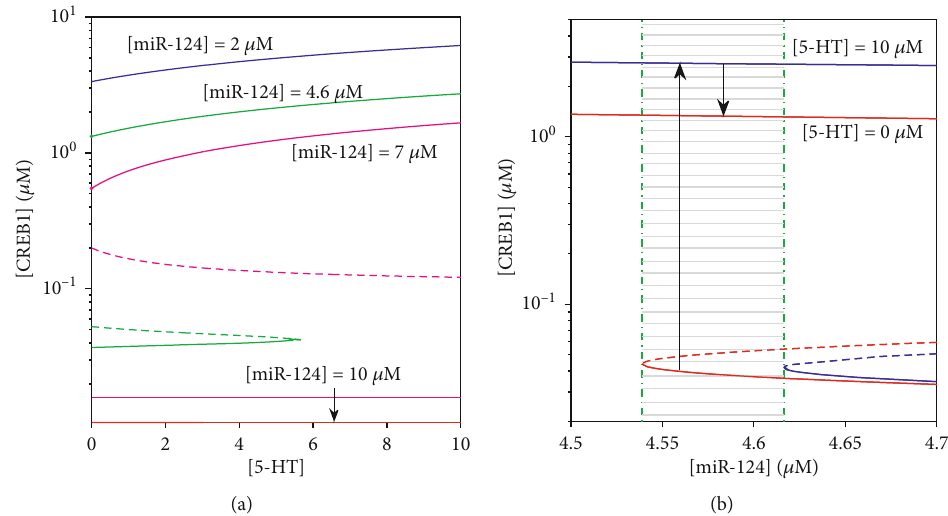
Figure 6: Bifurcation diagrams of [CREB1] versus [5-HT] for di ff erent [miR-124] (a) and [CREB1] versus [miR-124] at ½ 5 ‐ HT (cid:2) = 0 μ M (red lines) and ½ 5 ‐ HT (cid:2) = 10 μ M (blue lines) (b). Stable and unstable steady states are represented by solid lines and dashed lines, respectively.